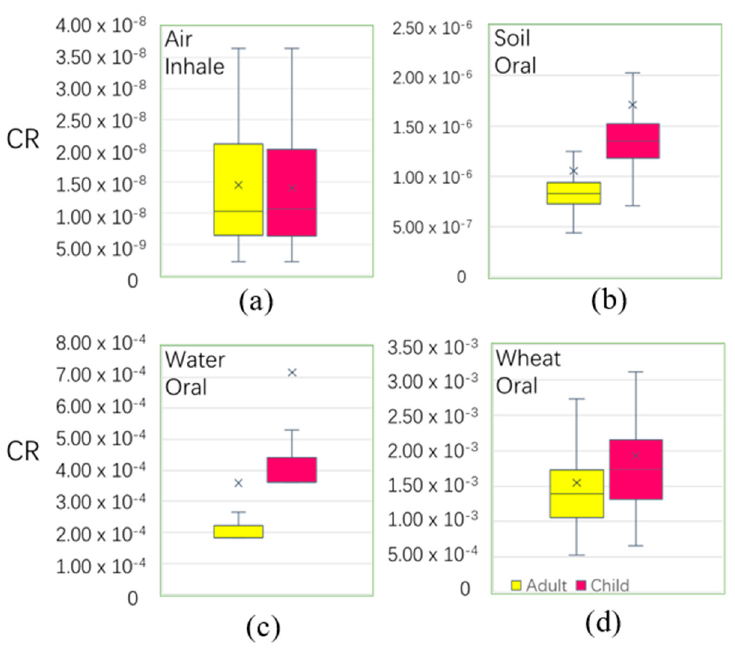
Figure 8. Boxplot of carcinogenic risk among different exposure pathways. (the total cancer risk (CR) is unitless).